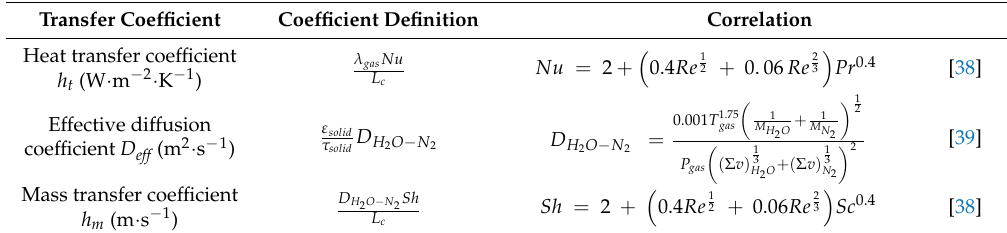
Table 8. Definition of transfer